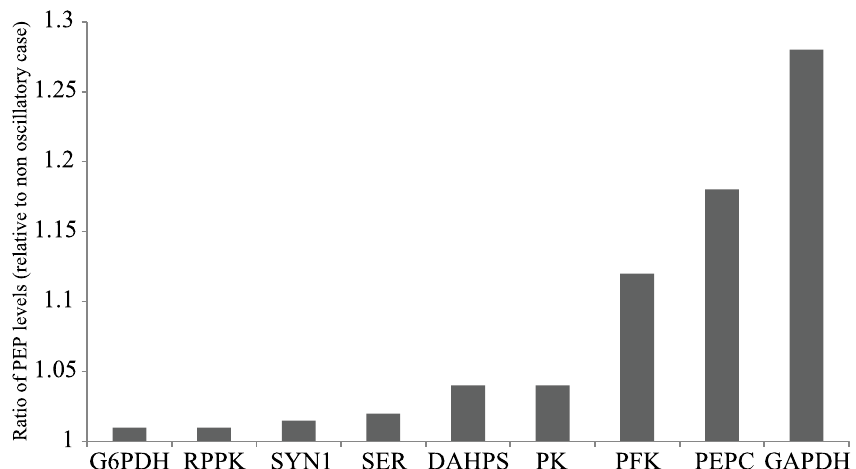
Figure 3. PEP concentration gains by oscillating individual enzymes. A comparison of the increase in total PEP concentration as a result of oscillating each of the indicated enzymes. The enzymes were oscillated by describing their levels as a cosine function and optimizing the properties of each wave. Gain in PEP levels is measured as a ratio of the total PEP concentration in the oscillating case over the total PEP concentration in the time invariant case. All optimizations were run over an 8 hour time horizon.